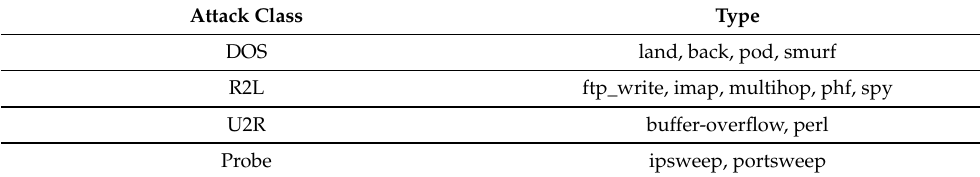
Table 5. Attack type and